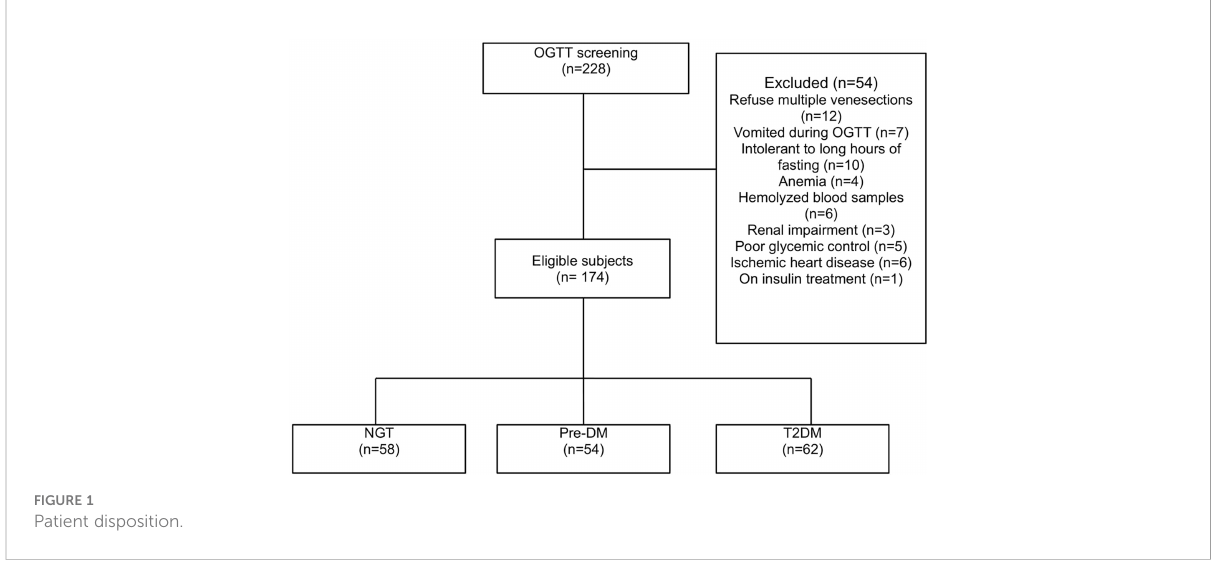
FIGURE 1 Patient disposition.